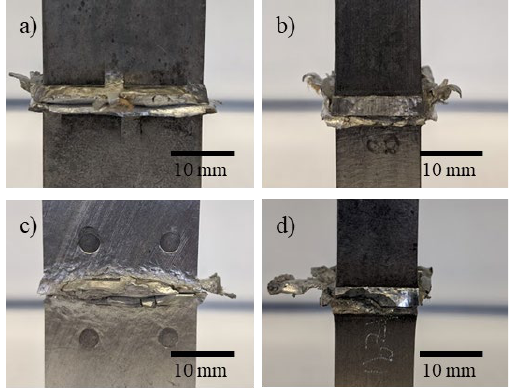
Figure 2. Front and side images of the welded ( a , b ) AZ91 and ( c , d ) AZ91–2Ca. Both similar Mg alloy welds display discontinuous flash